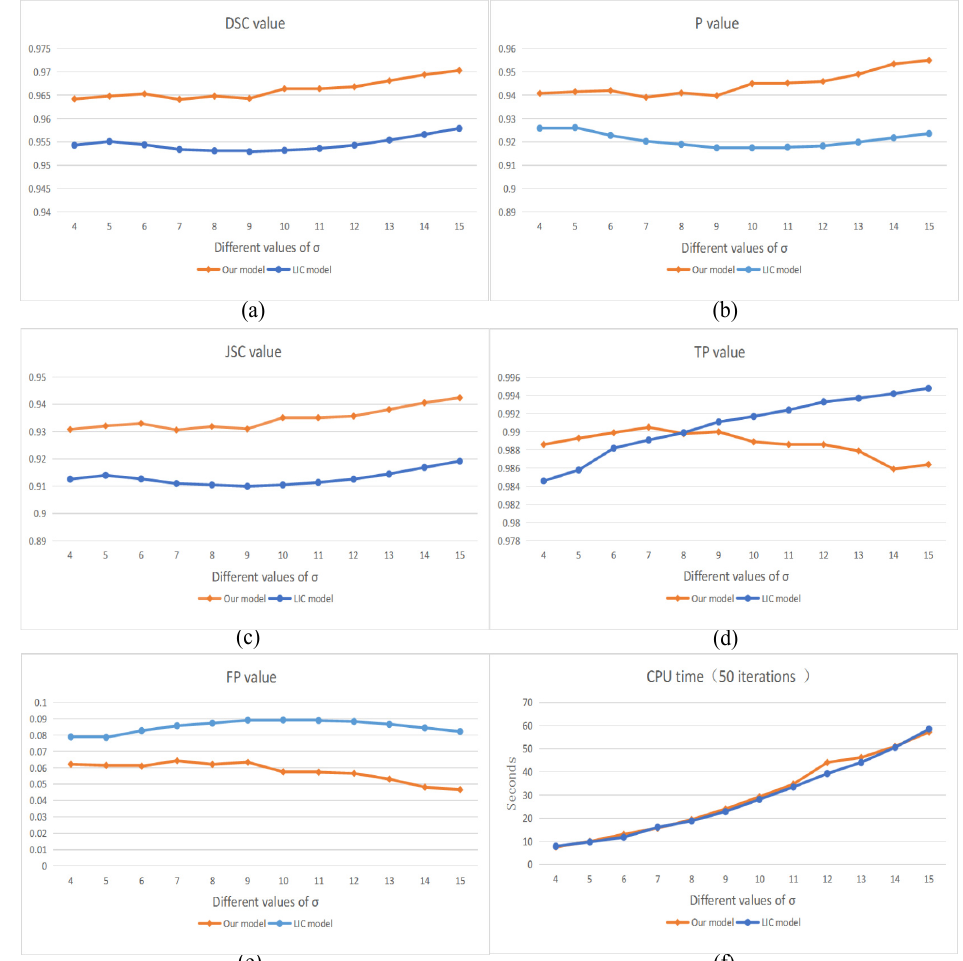
Figure 7. The corresponding evaluation index values of Figure 4 and comparison with the LIC model evaluation index values. ( a ) DSC values; ( b ) P values; ( c ) JSC values; ( d ) TP values; ( e ) FP values; and ( f ) CPU time values.